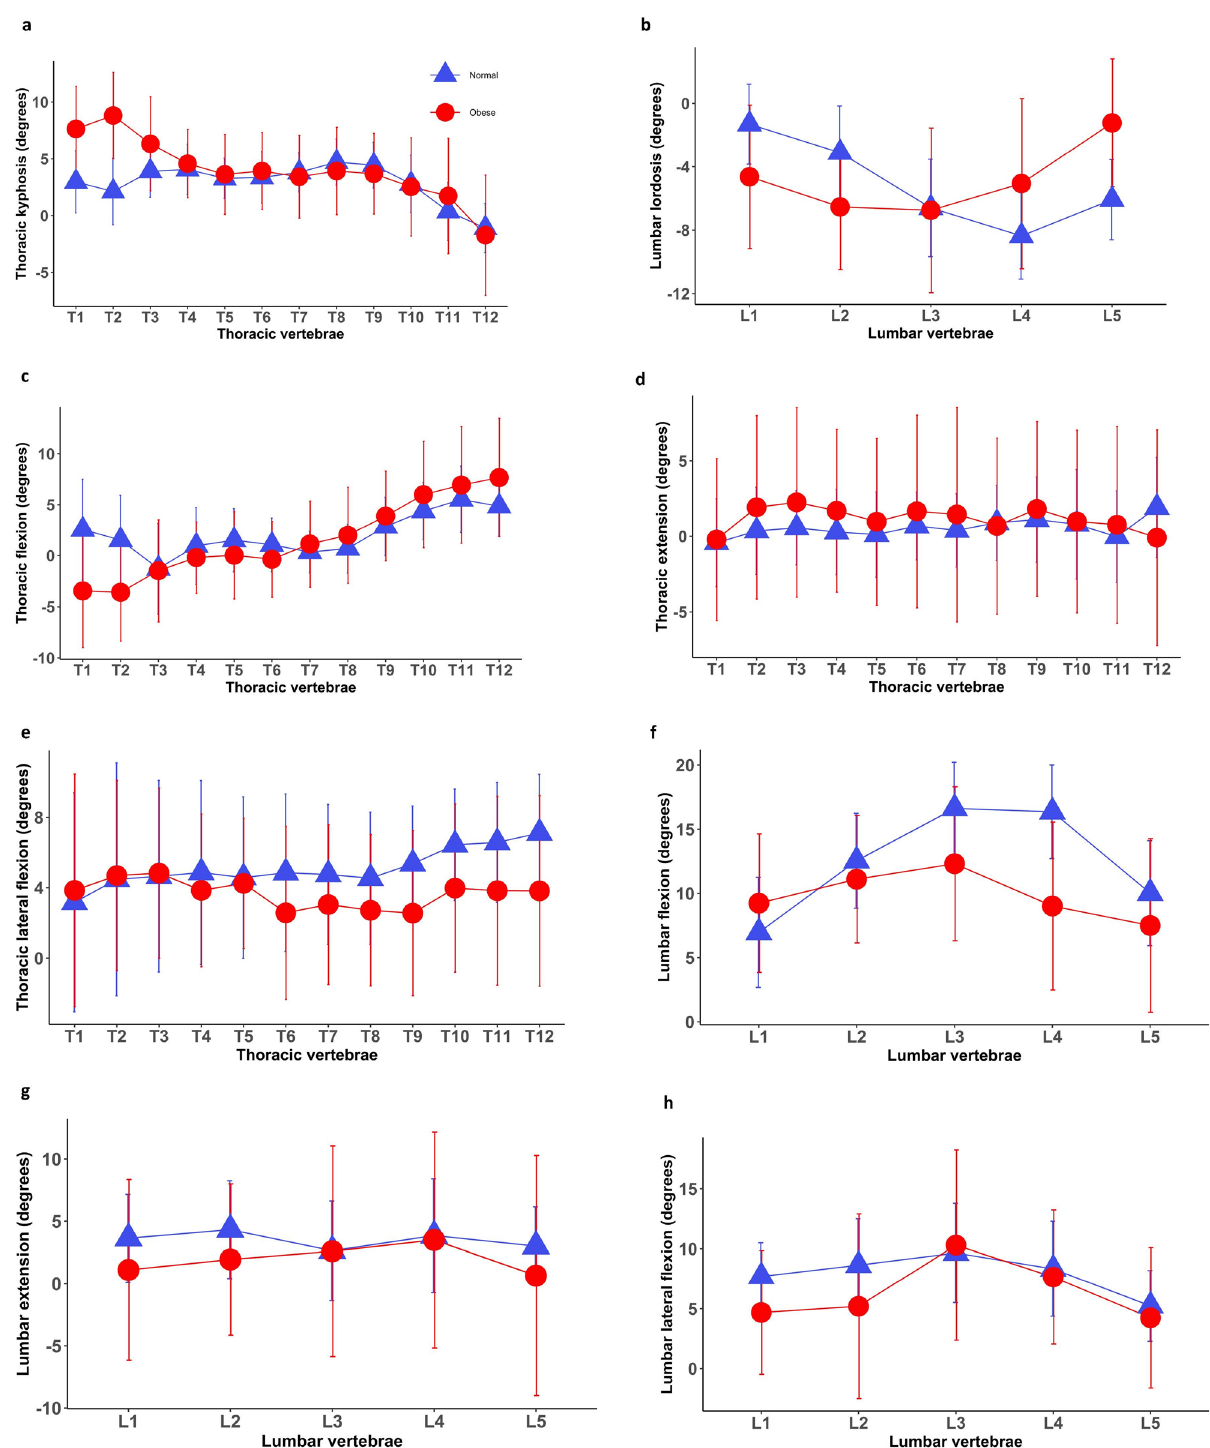
Figure 1. Posture and mobility of each individual spinal segment in the normal-weight and obese groups (mean ± standard deviations). Normal normal-weight group, Obese obese